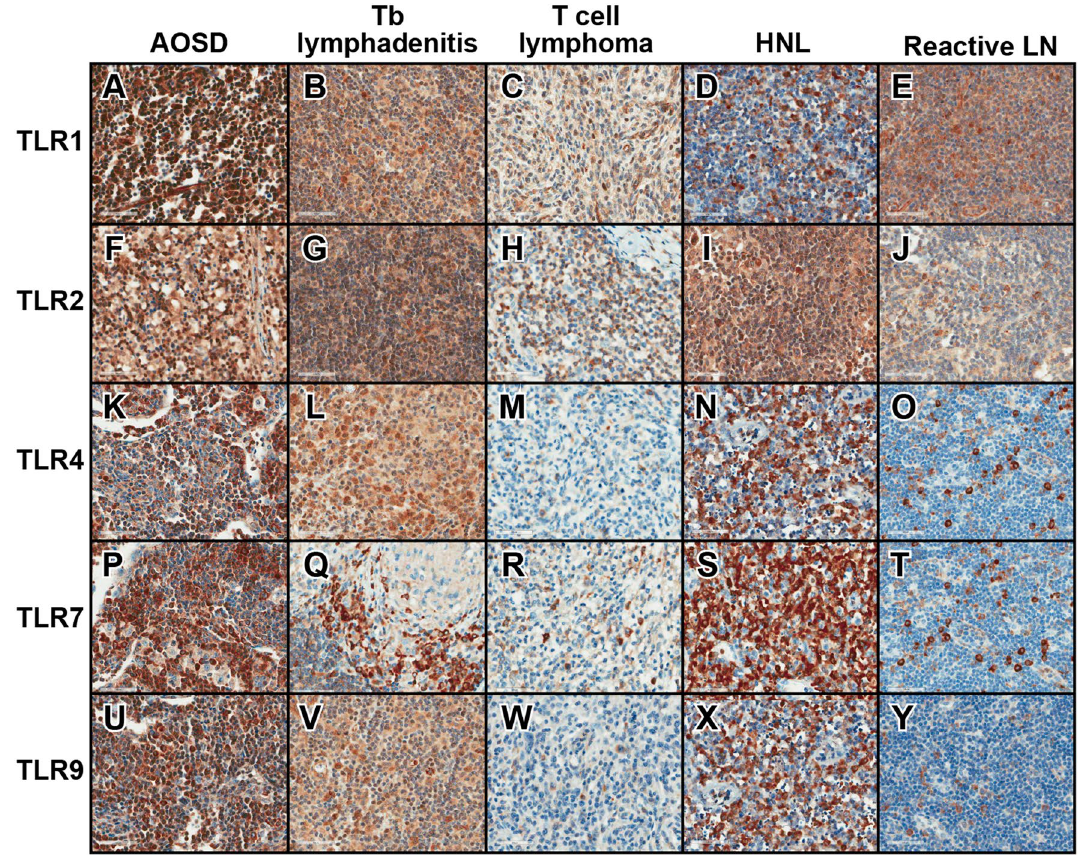
Figure 4. Toll-like receptor (TLR)1 ( A-E ), TLR2 ( F-J ), TLR4 ( K-O ), TLR7 ( P-T ), and TLR9 ( U-Y ) expression in lymph node (LN) biopsies of patients with adult-onset Still’s disease (AOSD) ( A,F,K,P,U ), tuberculosis (Tb) lymphadenitis ( B,G,L,Q,V ), T cell lymphoma ( C,H,M,R,W ), histiocytic necrotizing lymphadenitis (HNL) ( D,I,N,S,X ), and reactive lymphadenopathy ( E,J,O,T,Y ). Original magnification, × 100 or × 400. TLR1 was more frequently expressed in the LN of patients with AOSD than in that of patients with Tb lymphadenitis, T cell lymphoma or reactive LN. TLR2 was more frequently expressed in the LN of patients with AOSD than in that of patients with HNL. TLR4 was more frequently expressed in the LN of patients with AOSD than in that of patients with T cell lymphoma or reactive LN. TLR7 ware more frequently expressed in the LN of patients with AOSD than in that of patients with T cell lymphoma or reactive LN. TLR9 was more frequently expressed in the LN of patients with AOSD than in that of patients with T cell lymphoma or reactive